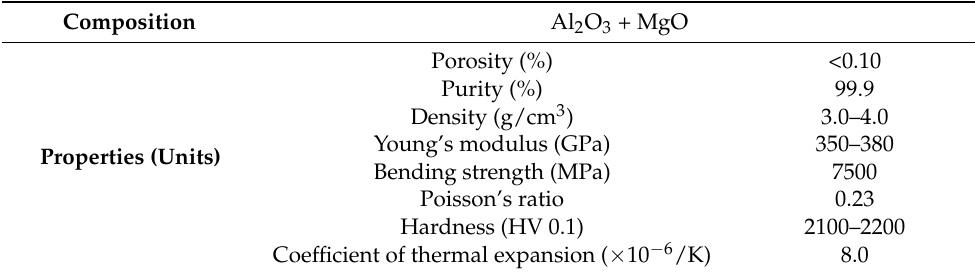
Table 1. Properties of alumina